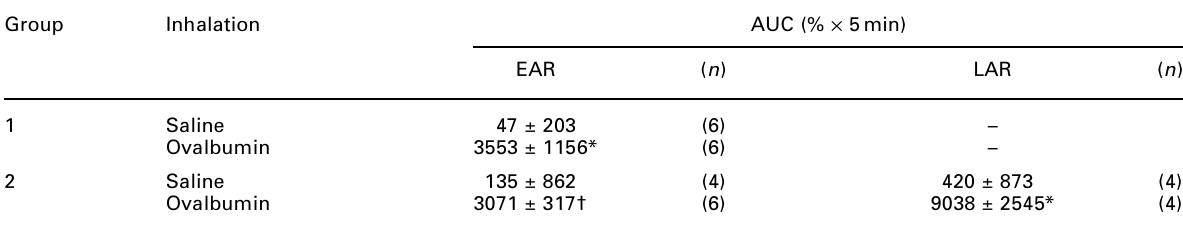
Table 1. Airway responses of sensitized guinea pigs after saline inhalation or ovalbumin